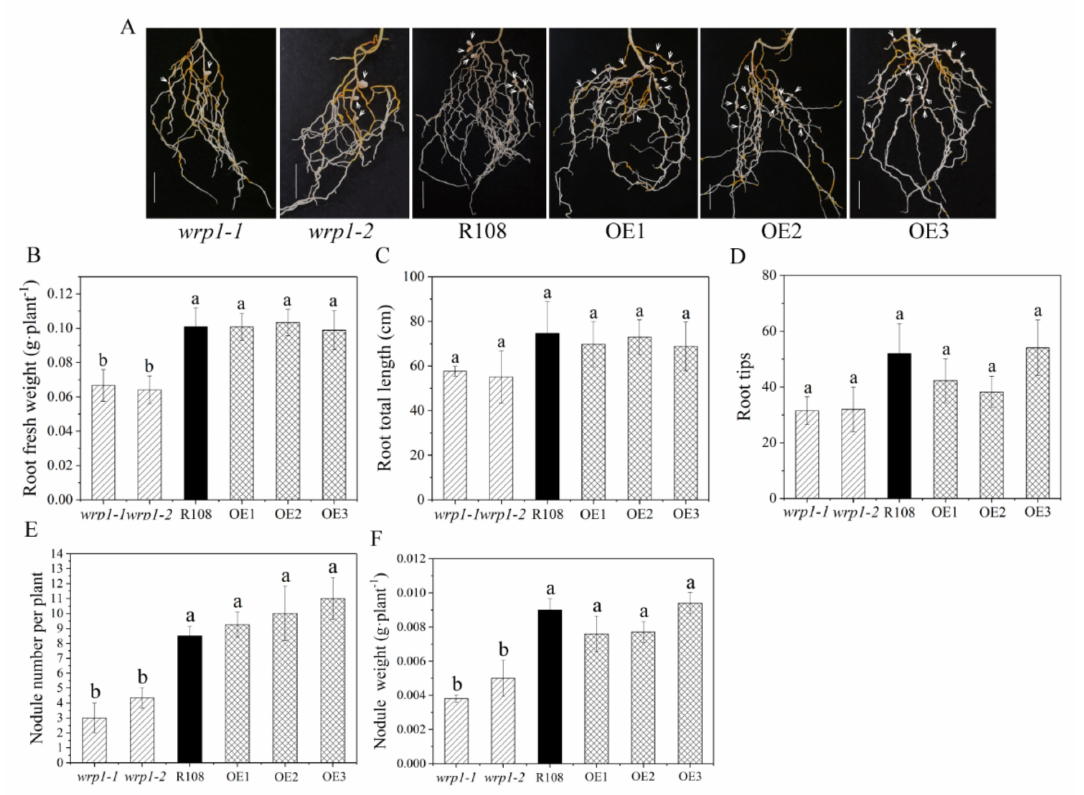
Figure 8. Effects of MtWRP1 on root growth and nodulation in M. truncatula: ( A ) Nodulation phenotype of MtWRP1 mutants ( wrp1-1 and wrp1-2 ), R108, and transgenic M. truncatula (OE1, OE2, and OE3) at 30 dpi under nitrogen-deficient conditions. Arrowheads indicated nodules. Bar, 1 cm. ( B ) The root fresh weights of MtWRP1 mutants, R108, and transgenic M. truncatula . ( C ) The root total lengths of MtWRP1 mutants, R108, and transgenic M. truncatula . ( D ) The root tips of MtWRP1 mutants, R108 and transgenic M. truncatula . ( E ) The nodule number of MtWRP1 mutants, R108, and transgenic M. truncatula . ( F ) The nodule weights of MtWRP1 mutants, R108, and transgenic M. truncatula . Data represent mean ± SD ( n = four independent biological replicates). Different letters above the standard error bars indicated a significant difference between the lines as determined by Duncan’s multiple range test ( p <